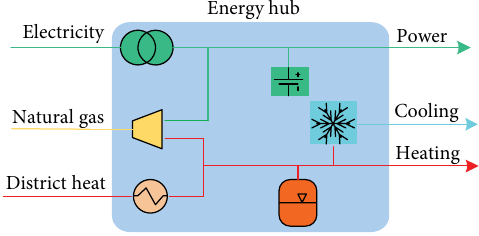
Figure 3: Basic model of energy